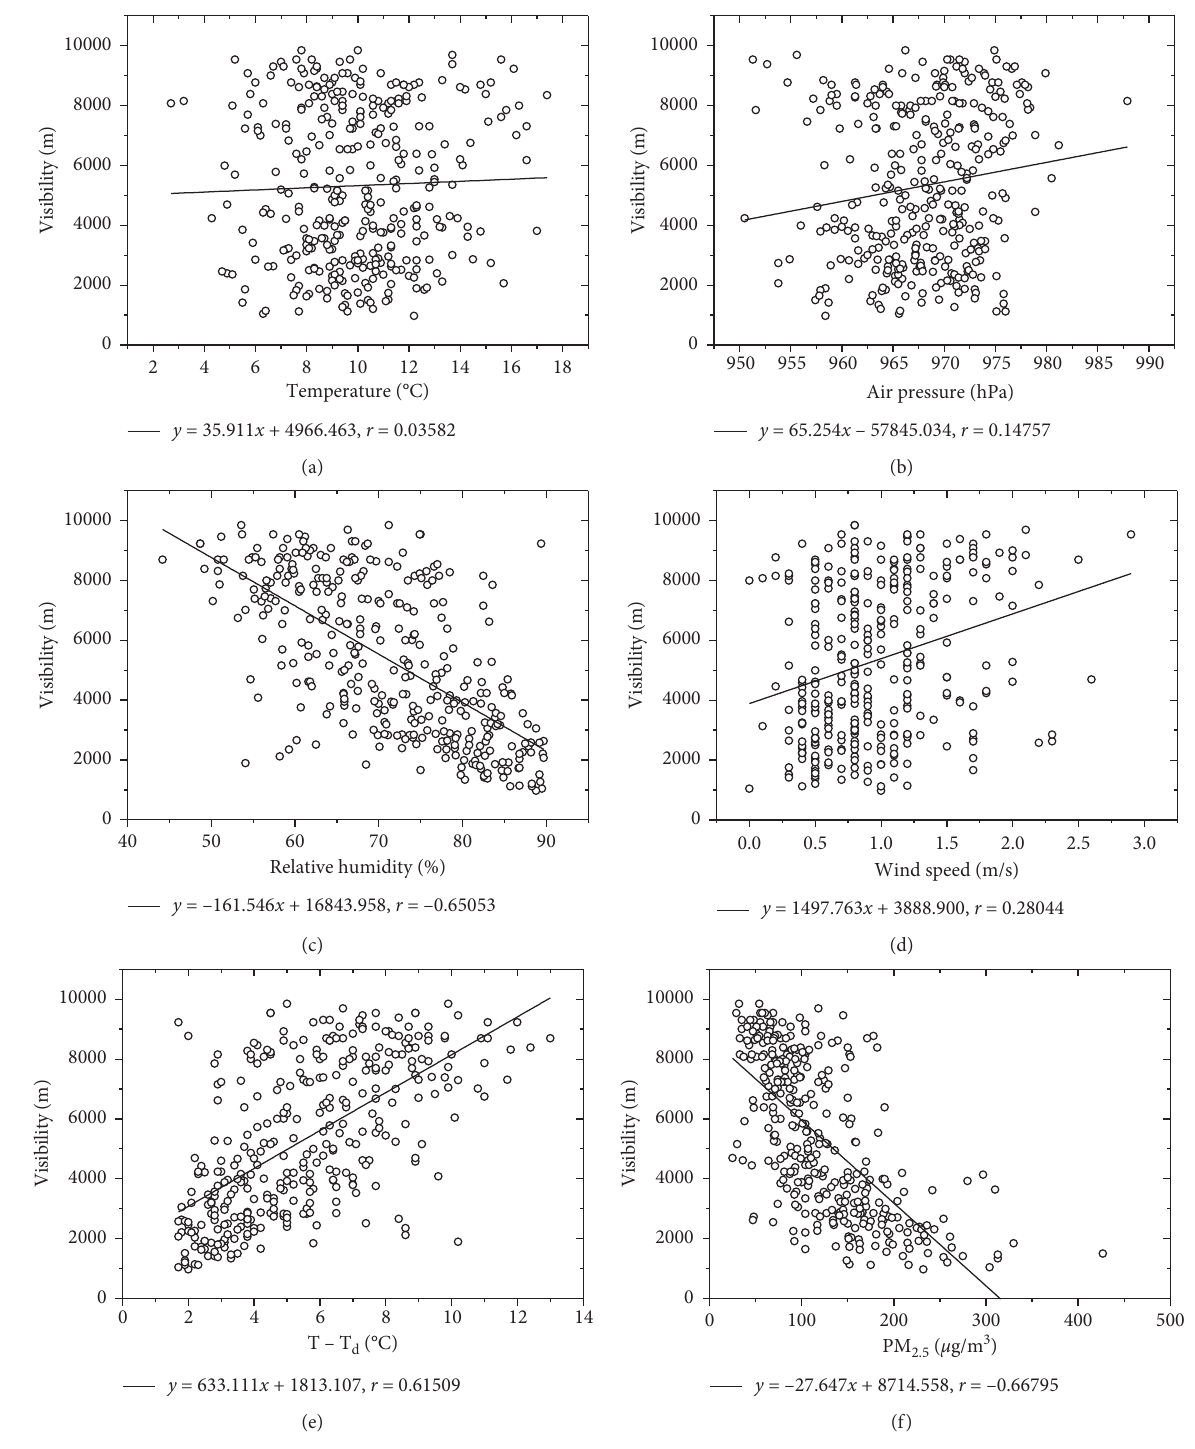
Figure 4: Relations between visibility and temperature (a), air pressure (b), relative humidity (c), wind speed (d), dew point depression (e), and PM 2.5 concentration